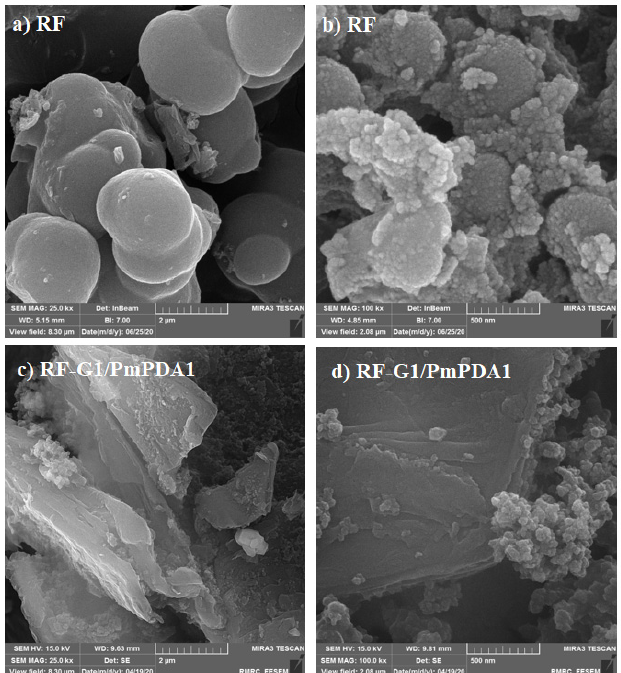
Fig. 3. The FESEM images of RF and RF-G1/PmPDA1 aerogels at a, c)25K and b, d)100K magnification